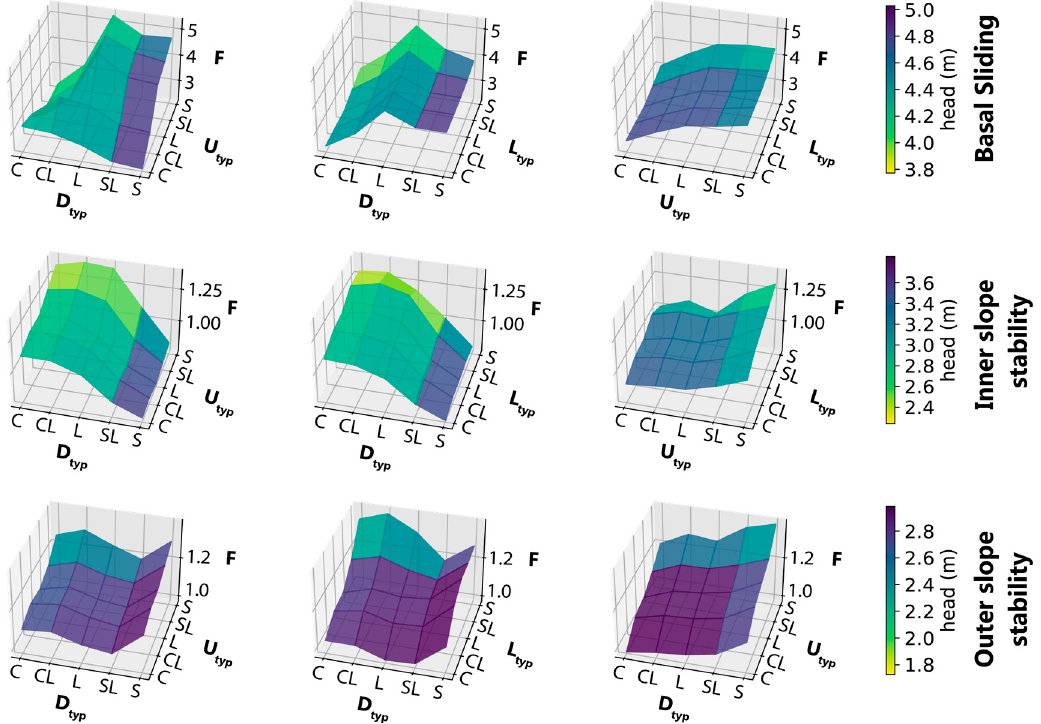
Figure 9. Response surfaces of dike stability F on different combinations of dike and subsurface properties. Low factors of safety clearly coincide with high (darker blue) hydraulic heads for each failure mechanism. Note the different scales for both the y-axis ( F ) as the colors (heads).